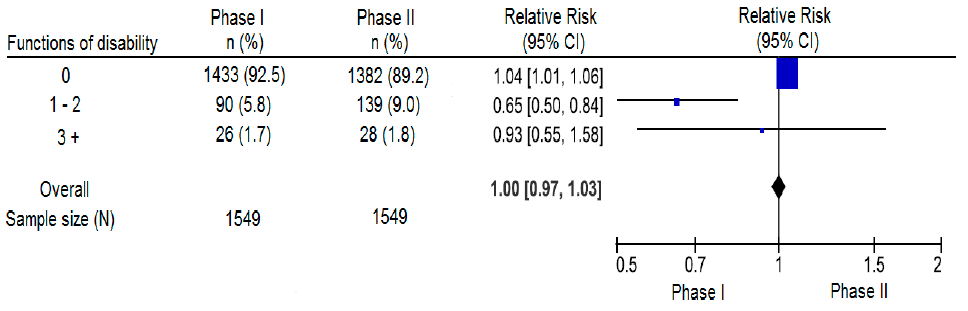
Table 4. Odds ratios and 95% CIs obtained from a GEE logistic regression model showing the changes in distress between disabled and non-disabled.